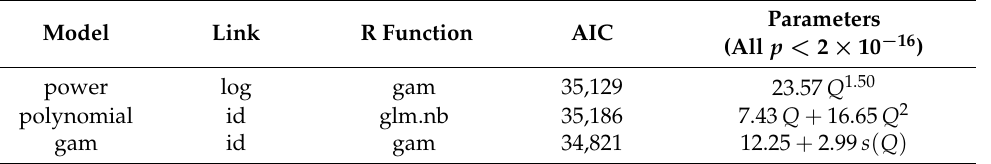
Table 1. Results of the fits of the three models displayed in Figure 10.